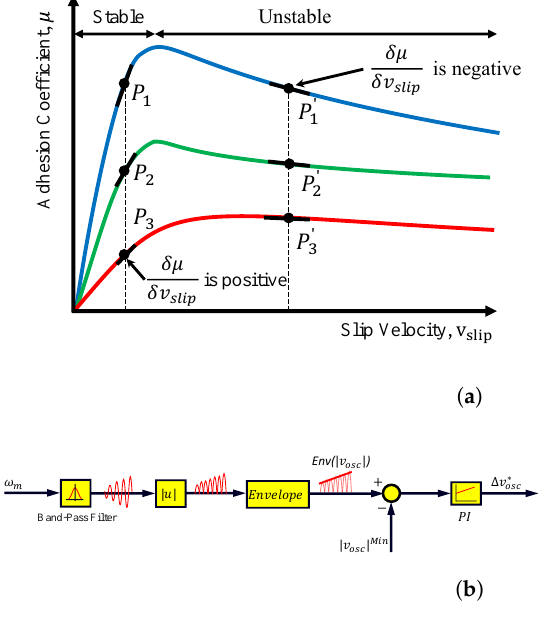
Figure 9. Torsional vibrations occurrence and mitigation method: ( a ) migration of operating point from stable (micro-slip) to unstable (macro-slip) regions, and ( b ) Vibration protection control